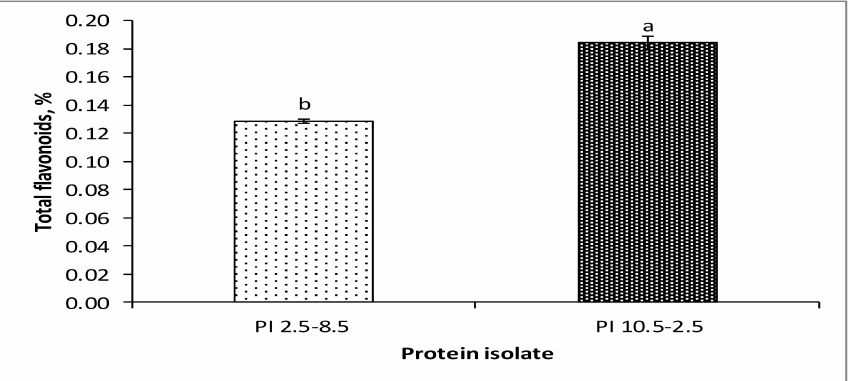
Figure 5. Total flavonoids content of ethanol-treated rapeseed meal protein isolates, PI 2.5–8.5 and PI 10.5–2.5 . a,b Means with different superscripts differ significantly ( p < 0.05). Concerning total phenols, PI 2.5–8.5 was the isolate containing a higher amount (0.71%) than PI 10.5–2.5 (0.42%) [21]. Phenols are a large group of secondary plant metabolites